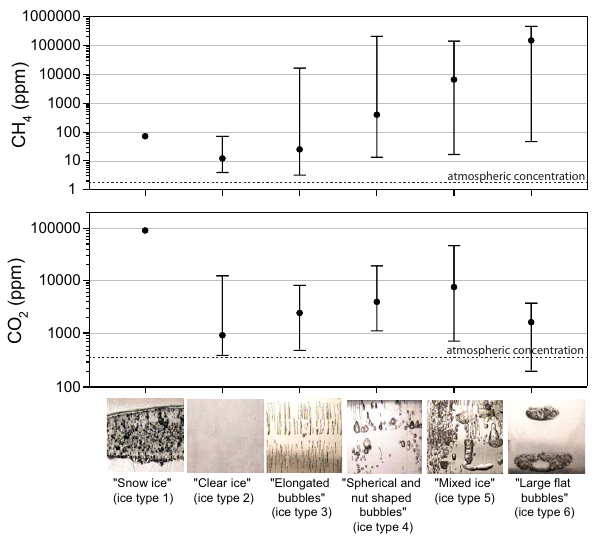
Fig. 5. Ice types classification from bubble shapes and density, with associated ranges of CO 2 and CH 4 mixing ratios. Note the logarith- mic mixing ratio scale. Black dots are median values and vertical bars represents the variability in the observations.